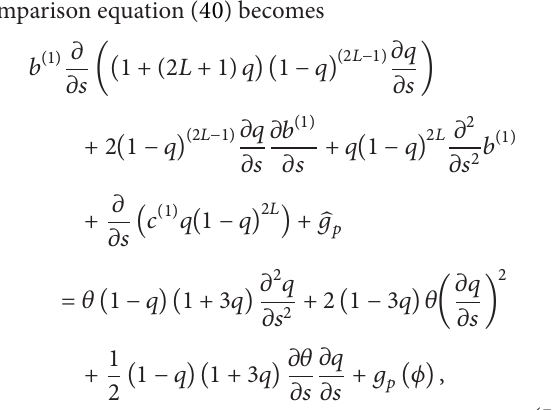
Figure 8: The comparison of the 1D controlled network and the location-invariant continuum limit at 𝑡 = 1 s. On the 𝑥 -axis, the × marks are the uniform grid, and the Δ marks are the nonuniform node